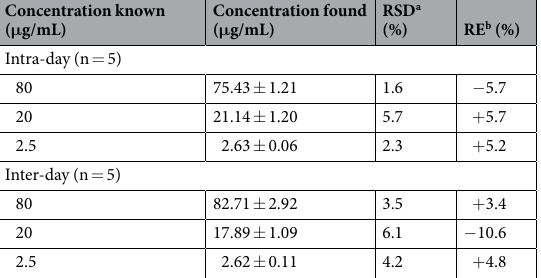
Table 1. Precision and accuracy of analyses of ibuprofen in human plasma. a Relative standard deviation (RSD) = (SD/mean) × 100. b Relative error (RE) = (Concentration found − Concentration known/ Concentration known) ×